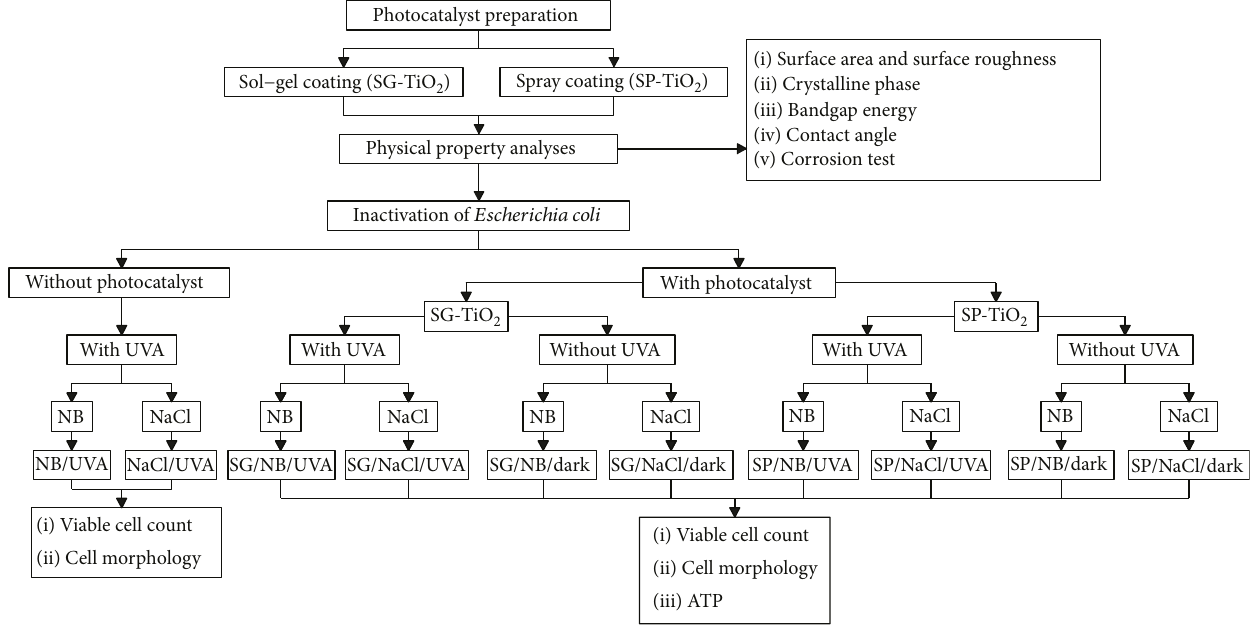
Figure 3: The overall scheme of this experimental